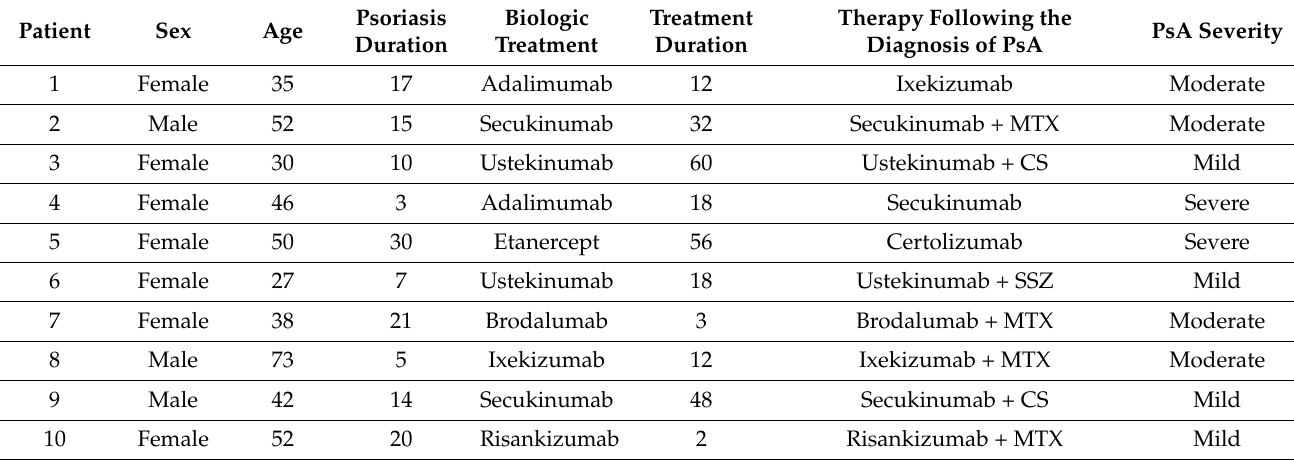
Table 2. Patients who developed new-onset PsA during biologic treatment: general features, treatment, and PsA severity. MTX: methotrexate, SSZ: sulfasalazine, CS: oral